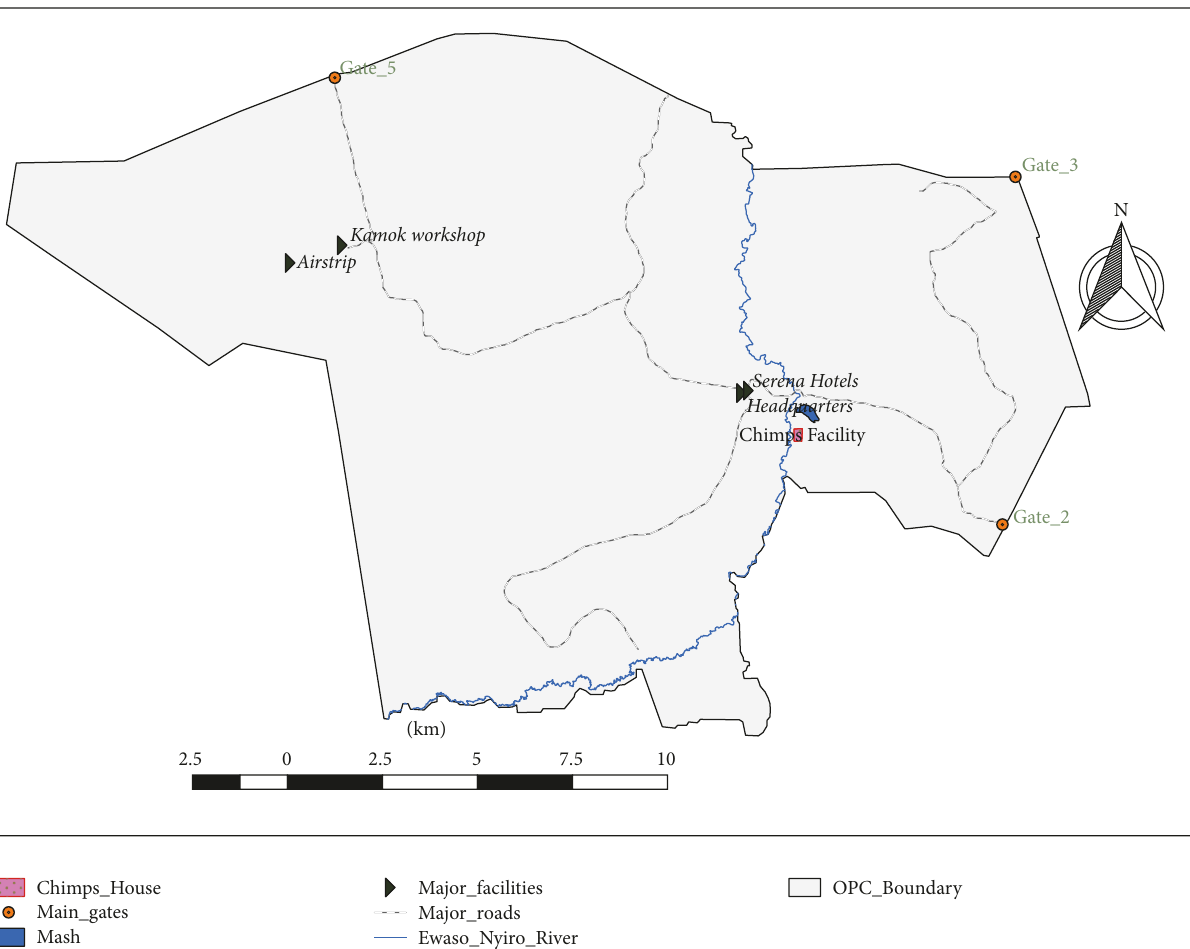
Figure 1: Map of the study